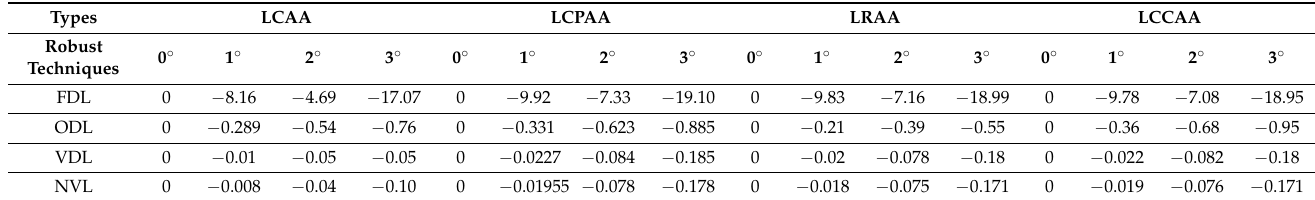
Table 2. Comparison of the power patterns for all